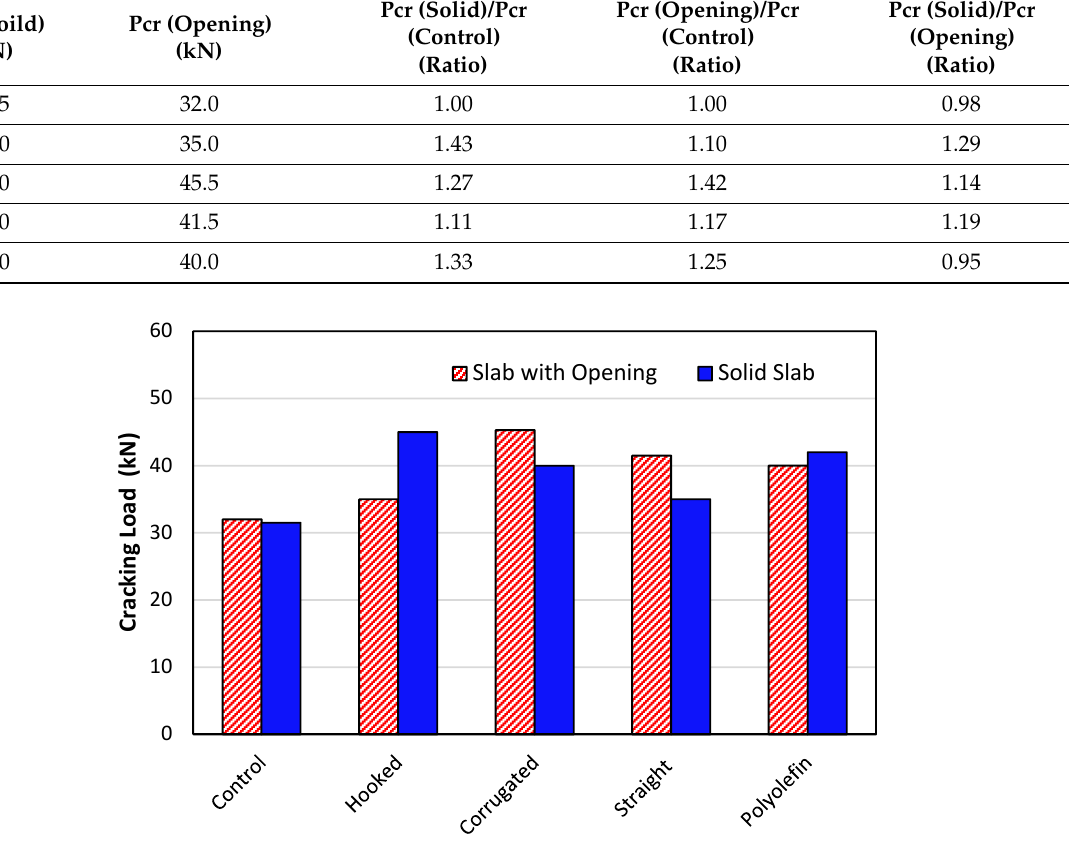
Figure 8. Effect of fiber type on cracking load. Table 7. Cracking and ultimate load of specimens for solid slab.